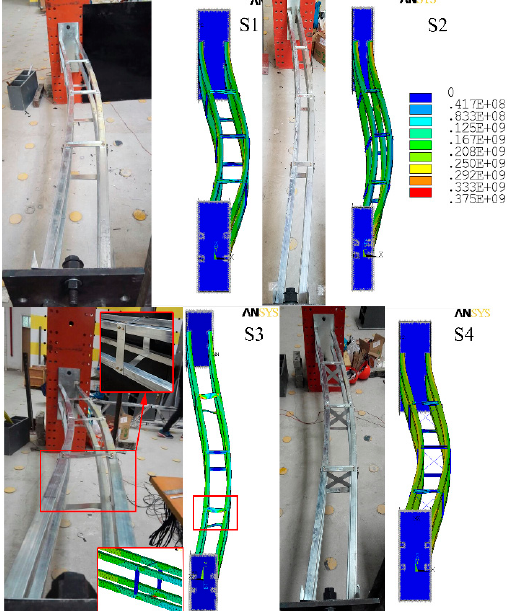
Figure 11. Numerical simulation results and details ( a ) Load-axial shortening curves of S1; ( b ) Curve of spring force and displacement.